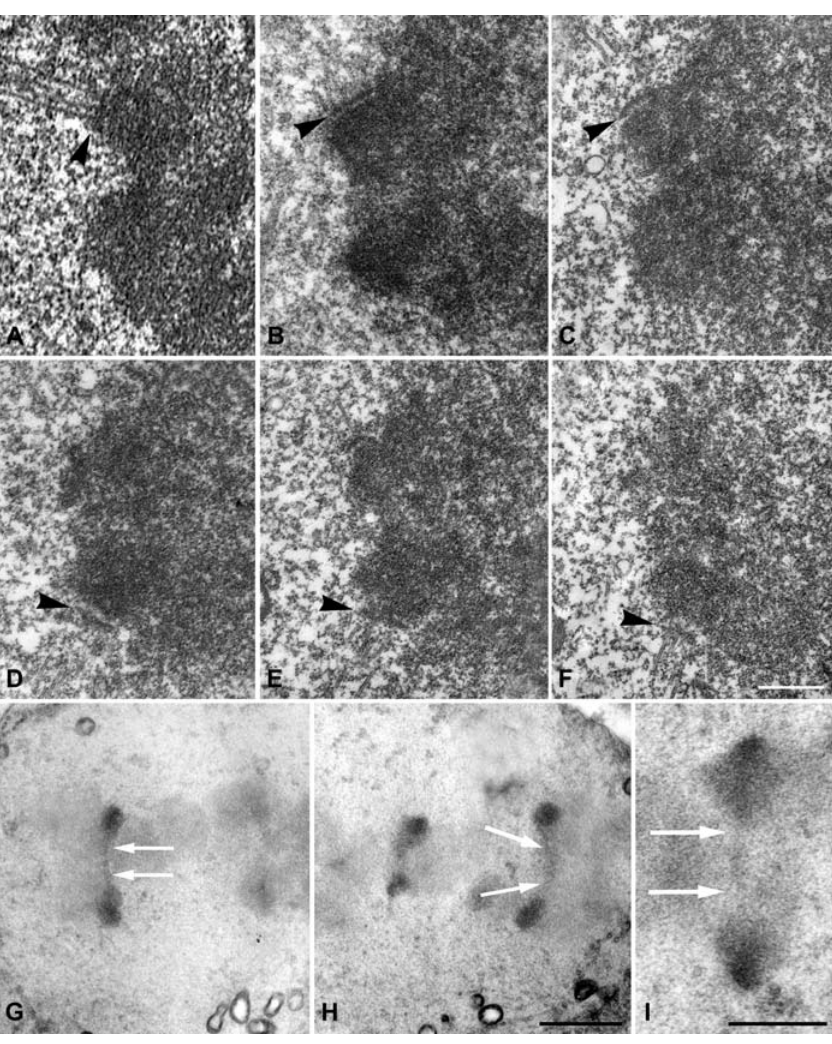
Figure 6. Ultrastructure of Metaphase II Centromeres (A–F) Six serial sections of a metaphase II centromere. Conventional technique. The outer plates of both sister kinetochores (arrowheads) are clearly differentiated. (G and H) Two sections of metaphase II centromeres after the Os-PPD technique. The condensed chromosomes show a very low contrast, while sister kinetochores show a high contrast. The kinetochores appear joined by a continuous band of medium contrast material (arrows). (I) Centromeric region of a chromosome in late metaphase II. A low contrast material extends as a thin and discontinuous band (arrows) joining the highly contrasted sister kinetochores. Bars, 0.5 l m (A–F), 2.5 l m (G,H), and 2.5 l m (I). DOI: